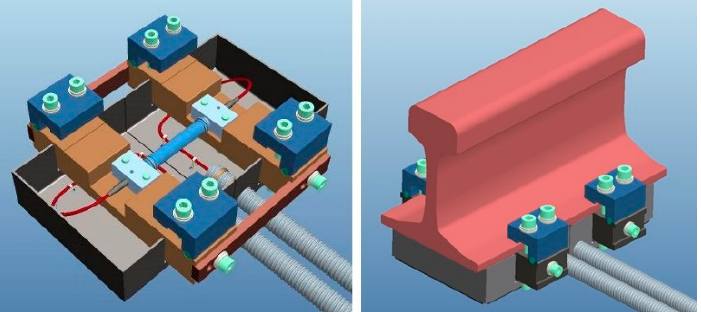
Figure 8. WIM–WILD sensor rendering [133].